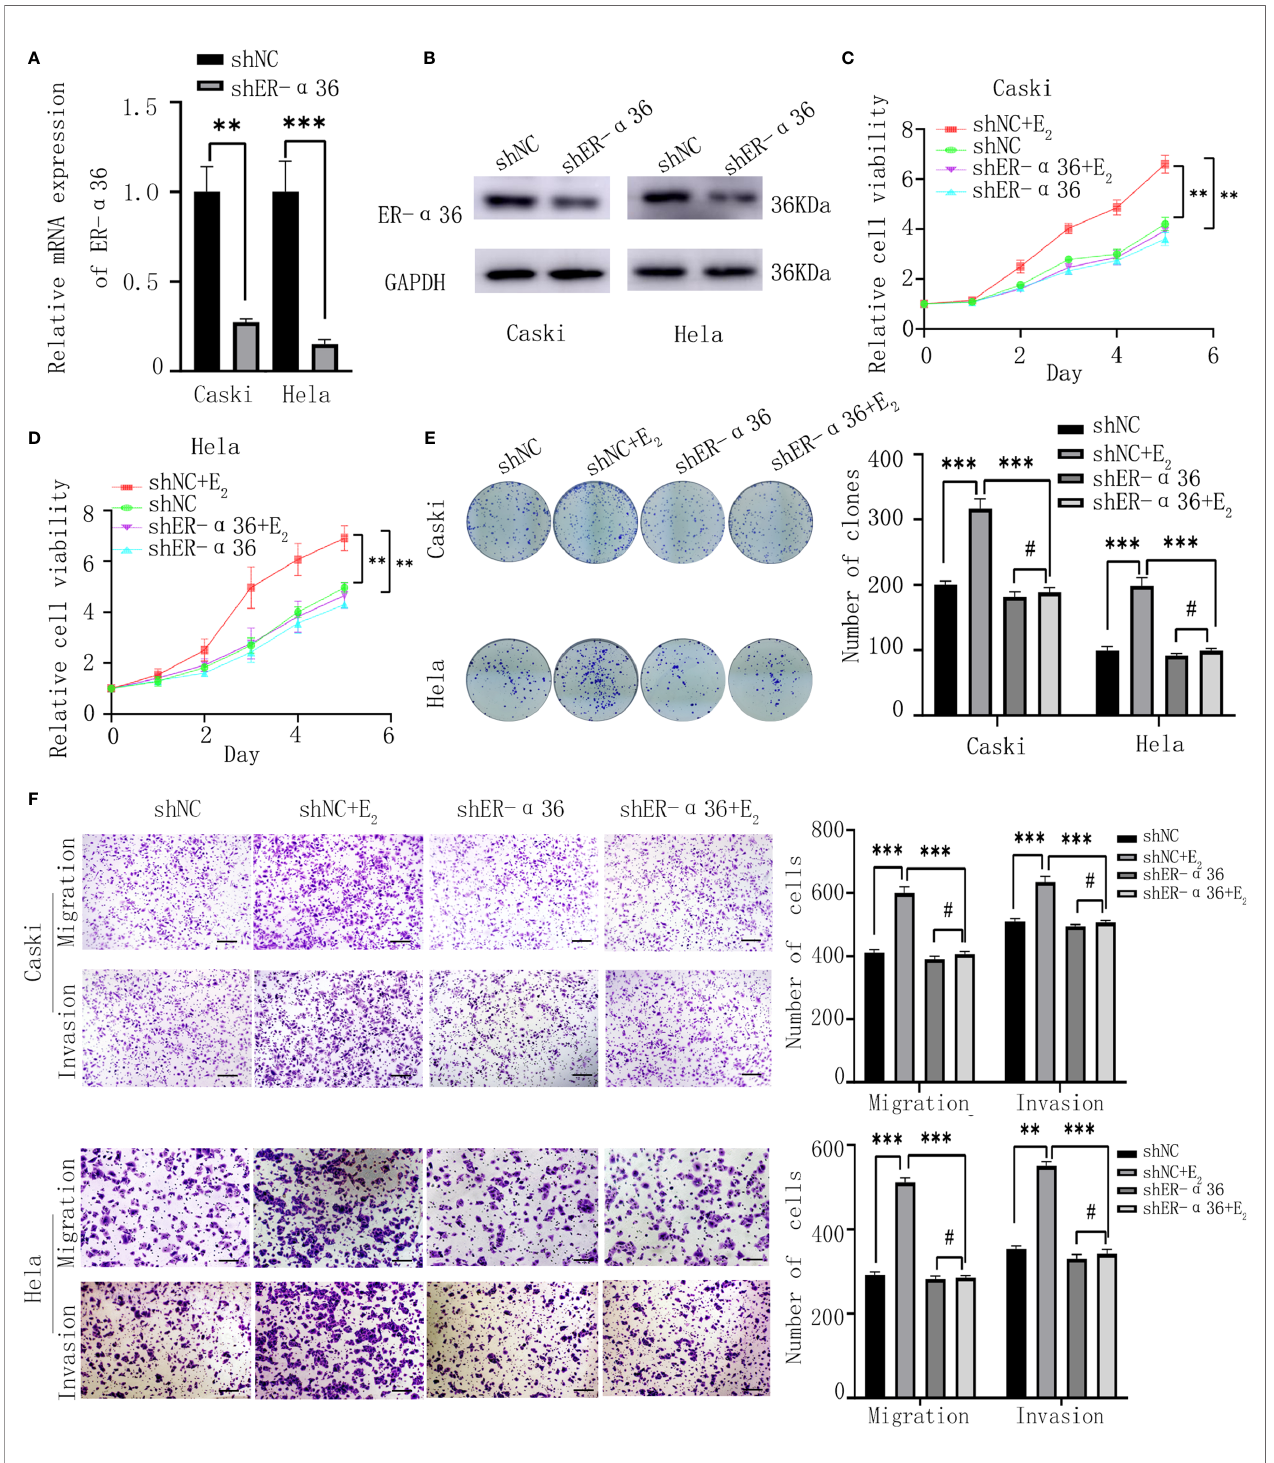
FIGURE 2 | ER- a 36 silence inhibits proliferation and metastasis of CC cells mediated by E 2 in vitro . Caski, hela cells were stably transfected with shNC, shER- a 36 and treated with ethanol or 1nM E 2 . (A, B) qRT ‐ PCR and western blotting analysis of the mRNA and protein levels of ER- a 36 in transfected caski and hela cells. (C, D) Proliferation of transfected caski and hela cells was measured by CCK-8 assay. (E) Colony formation ef fi ciency of caski and hela cells were assessed by clonogenic assay after ER- a 36 knockdown. (F) Migration and invasion of caski and hela cells were evaluated by transwell assay after ER- a 36 knockdown. Scale bar: 50 m m. (Data are mean ± SEM, # p > 0.05, **p < 0.01, ***p < 0.001, n =